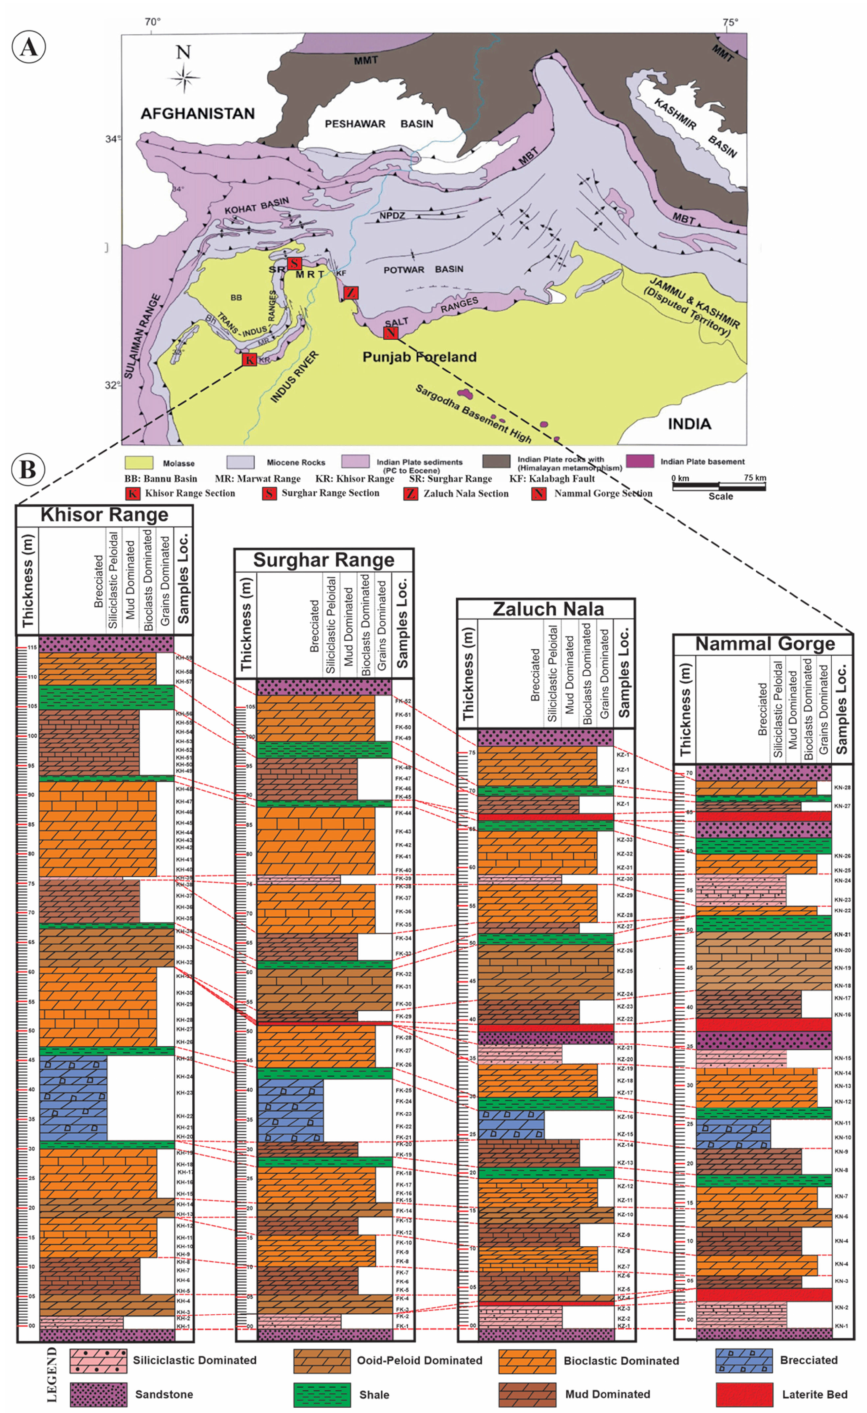
Figure 1. ( A ) Geological map of north Pakistan showing location of the studied sections in Kohat and Potwar sub-basins (after Kazmi and Jan [31]). ( B ) Diagram illustrating the measured stratigraphic sections in the Kohat (Khisor and Surghar ranges) and Potwar (Zaluch Nala and Nammal Gorge) sub-basins, respectively. Lateral and vertical facies variation with their respective sedimentary features (sandy, brecciated, mud dominated, bioclastic dominated, and ooidal-peloidal dominated) are displayed on each log. Lithofacies variation with respect to their depositional setting is also marked by the marker horizons of shale, sandstone, and laterites. The logged sections possess the sample locations and thickness of each facies. Lower contact with Tredian Formation and upper contact with Datta Formation at each section is exposed and has been